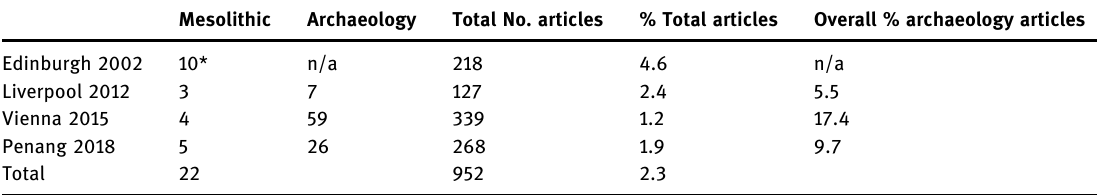
Table 2: Mesolithic contributions to CHAGS based on analysis of titles of presentations for Edinburgh 2002 and abstracts